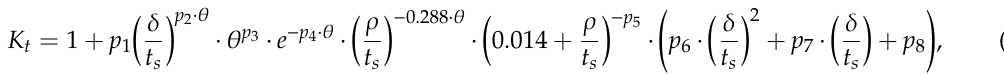
Table 2. Coefficients in Equation (4).